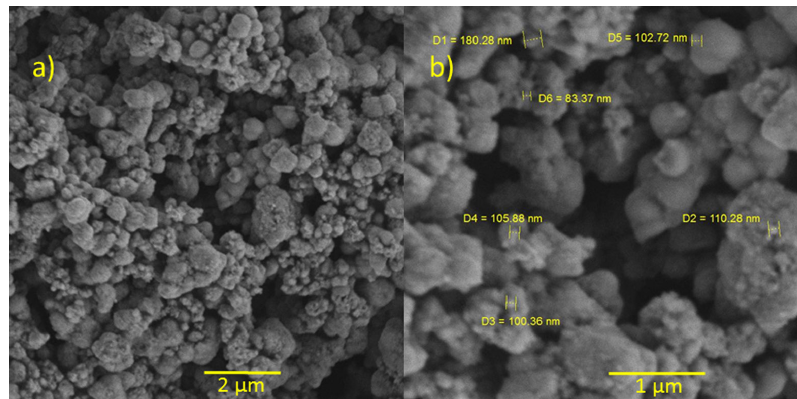
Figure 3. SEM micrographs of the Fe-Nb powder prepared.